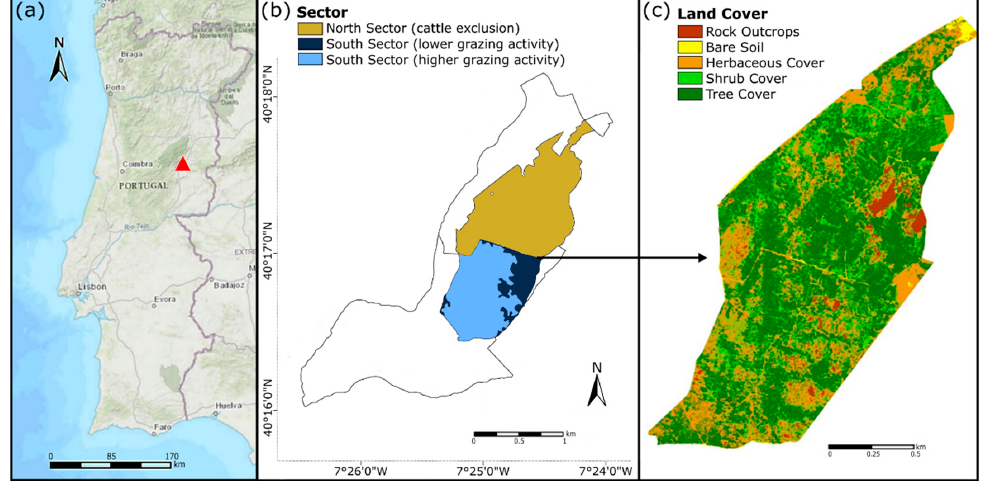
Figure 1. ( a ) Location of Quinta da França in Portugal (40°17 ′ 1 ″ N, 7°24 ′ 45 ″ W); ( b ) Forest study area (colored) inside Quinta da França (black outer line), showing the two sectors separated by a fence: the north (control) in brown and the south (test) in blues. The area with more grazing is shown in darker blue; ( c ) High resolution landcover map overlapping the forest study area.